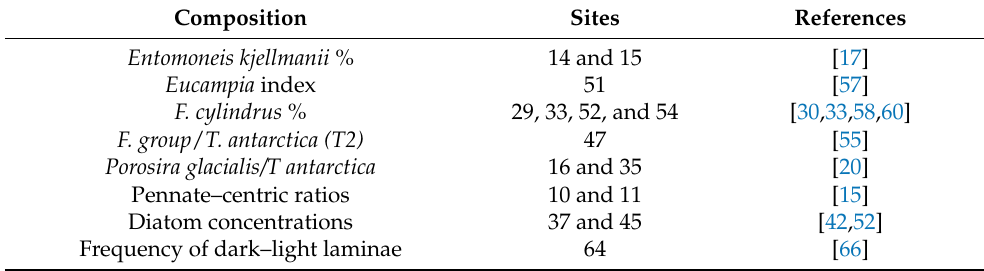
Table 7. Composition of all ‘other’ diatom proxies.